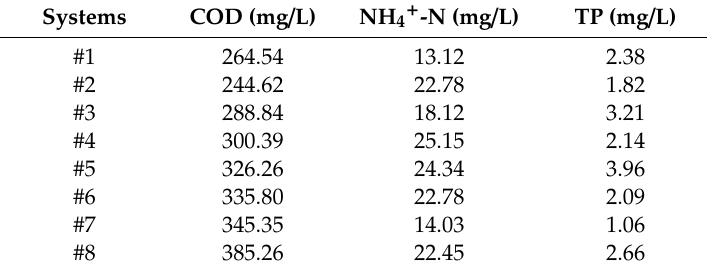
Table 1. The characteristics of the influent concentrations in the eight AAO Table 2. Operational parameters and control strategies of the HRTs optimization for #1, #2…, #8 AAO systems.